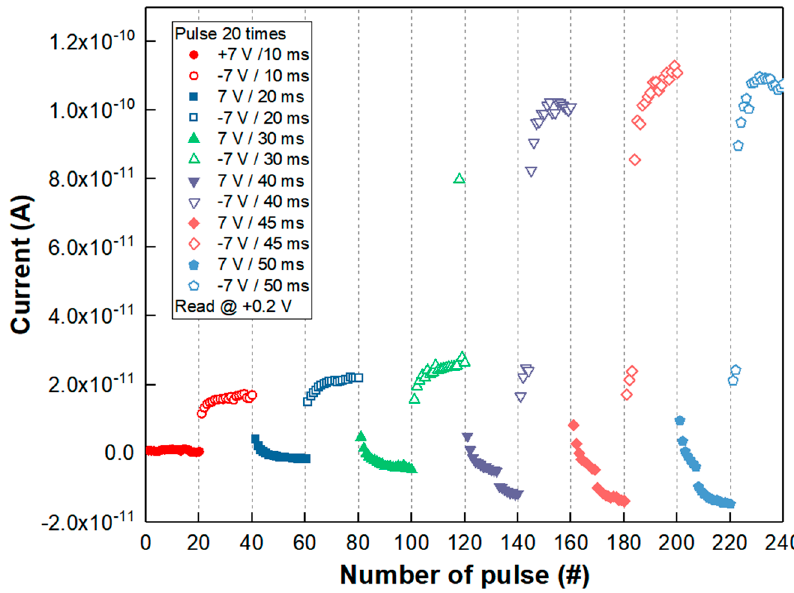
Figure 5. Current change of repeating pulses of +7V for 10 ms, 20 ms, 30 ms, 40 ms, 45 ms, 50 ms ten times for depression and, subsequently, repeating a pulse of -7V for 10 ms, 20 ms, 30 ms, 40 ms, 45 ms, 50 ms ten times for potentiation.